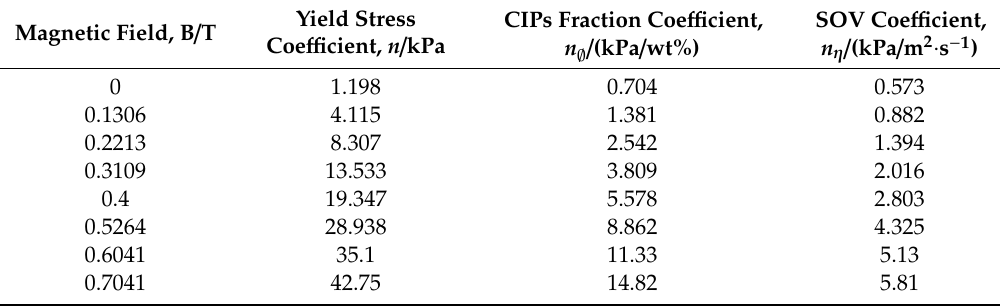
Table 5. Key parameters of MR grease under di ff erent magnetic field